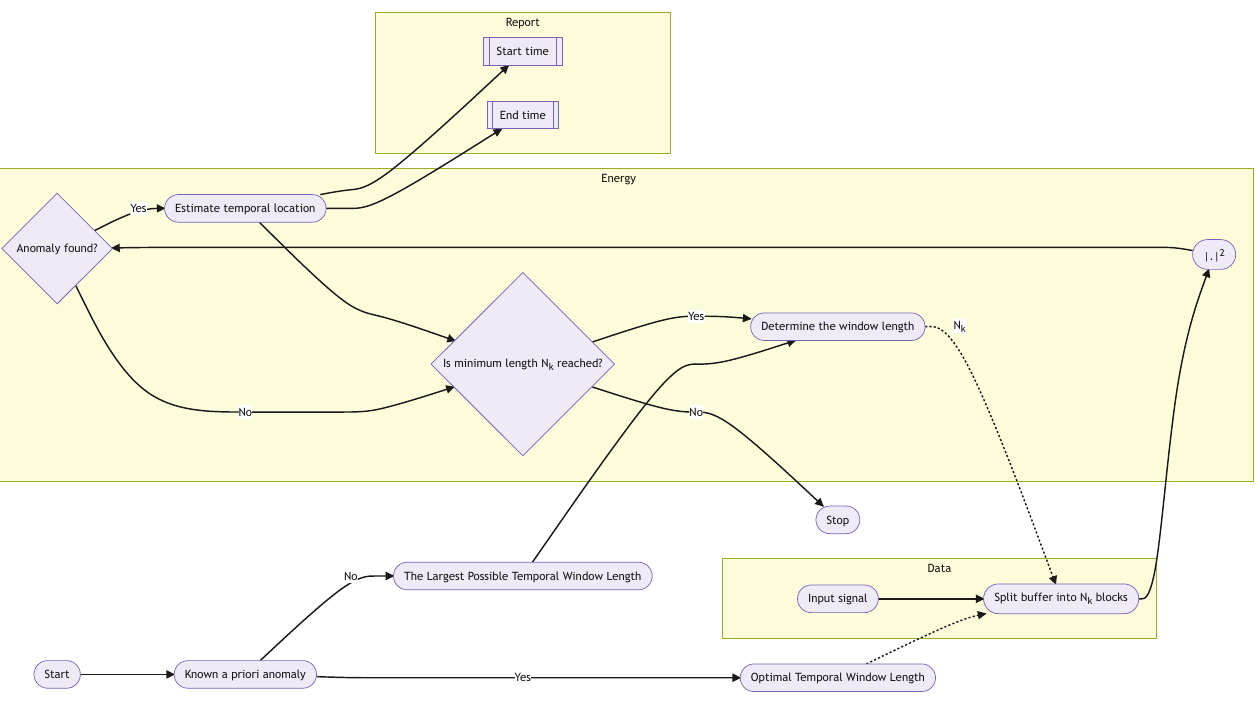
Figure 1. Illustration of the flowchart for the proposed energy detector